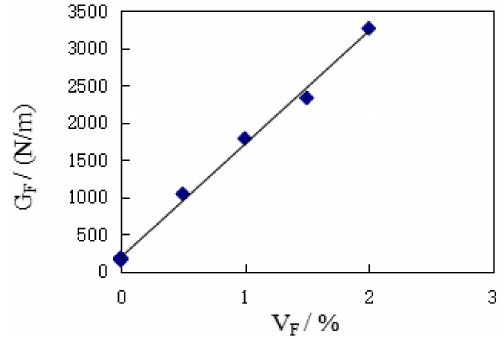
Figure 6. The effect of V F on G